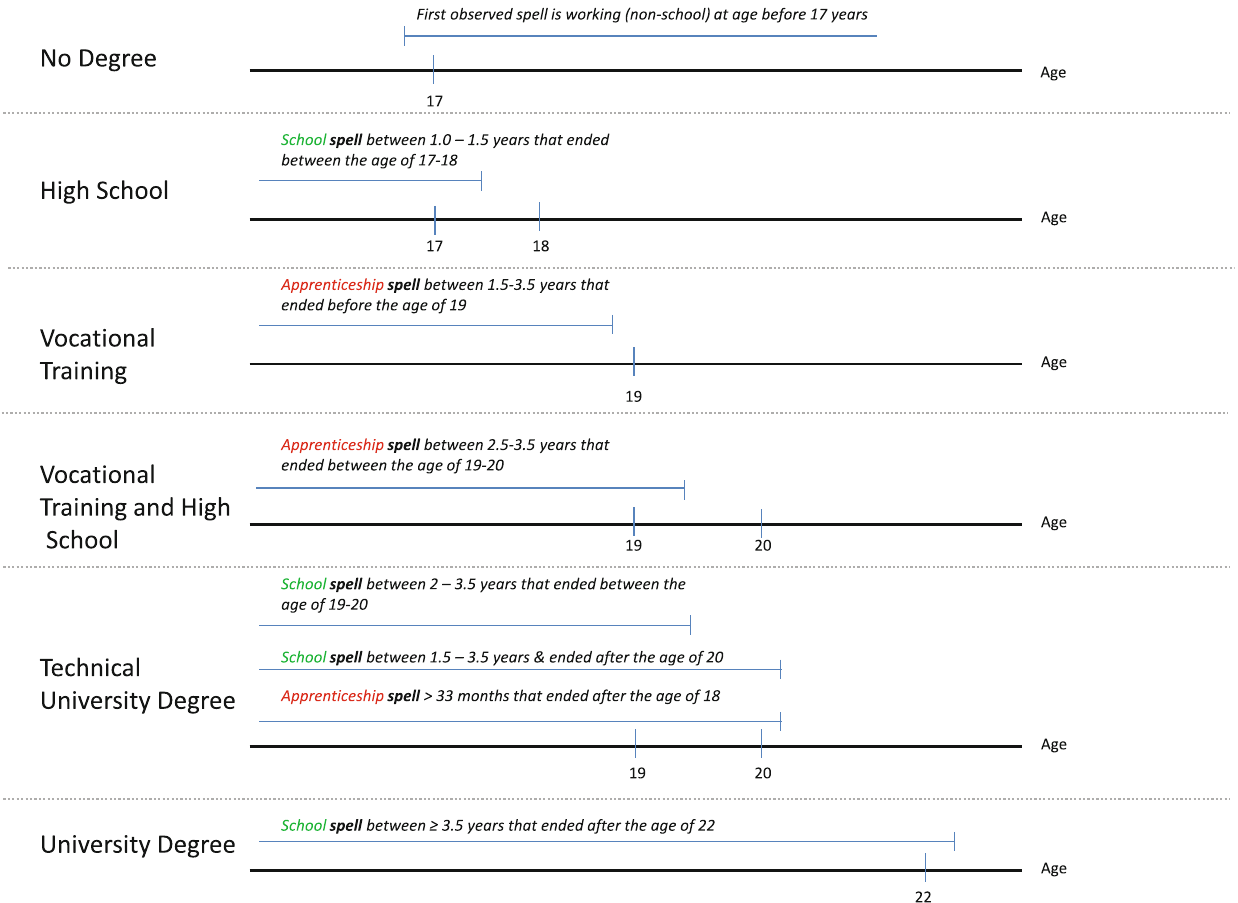
Fig. 5 Graphical Illustration of IMP1 . ( Notes: The graph illustrates the imputation rules for IMP1 . The rules are derived by combining the length of schooling and apprenticeship episodes with information on the educational system. The age thresholds refer to the end of the schooling and apprenticeship